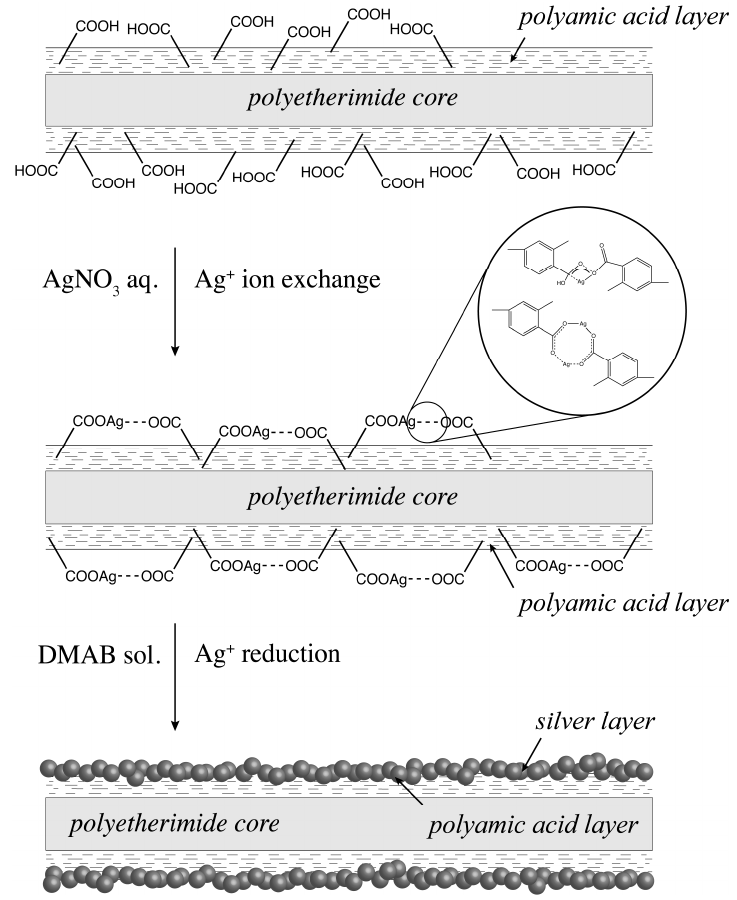
Scheme 1. Chemistry involved in the ion exchange of poly(amic acid) with metal ions.